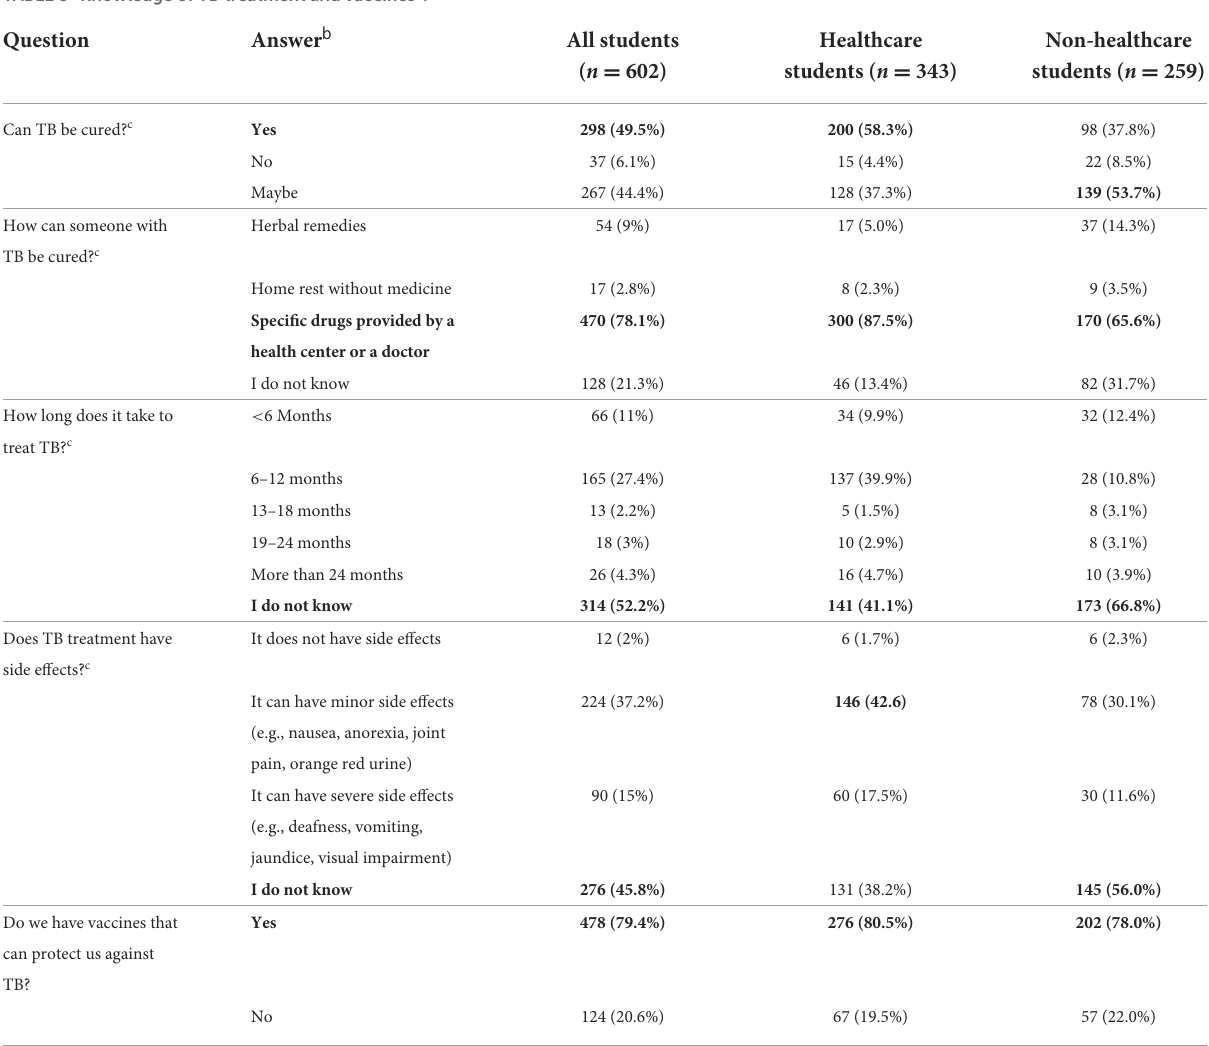
TABLE 3 Knowledge of TB treatment and vaccines a